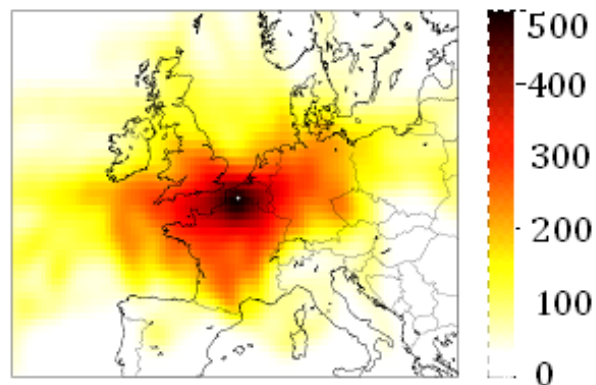
Fig. 2. Calculated back-trajectory density used to determine the weighing function coefficients, scaled by the number of back tra- jectories passing through each